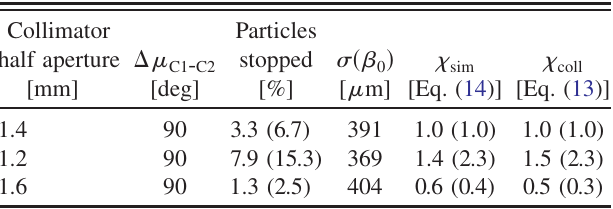
III. Comparison of the simulated and the analytical collimation performance for fixed C1-C2 phase advance and different collimator half apertures. The numbers in parentheses refer to the 2D collimation performed with rectangular jaws; in this case, the 2D collimation index is calculated as the product of the two 1D